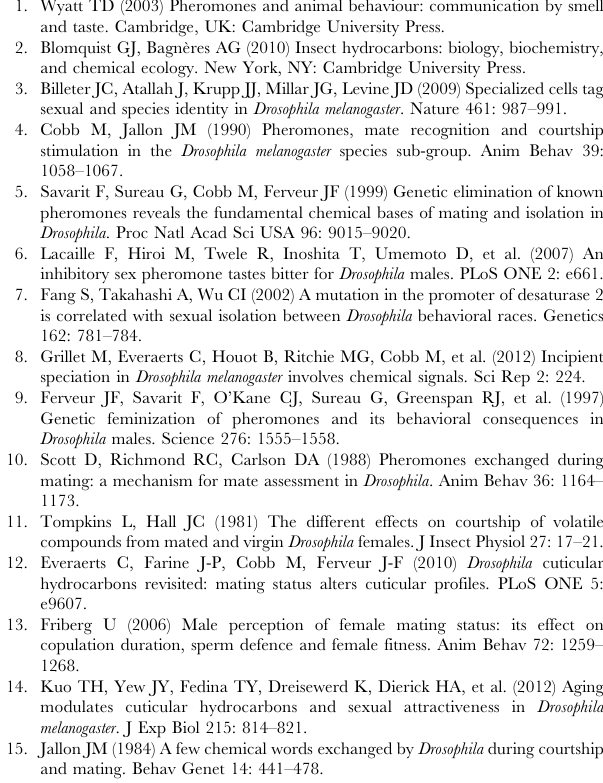
Figure S1 CHC profiles of individual flies. Chromato- grams are shown for 2 females from each of the following treatments: oe 2 , oe + , white (the donor females used for perfuming),